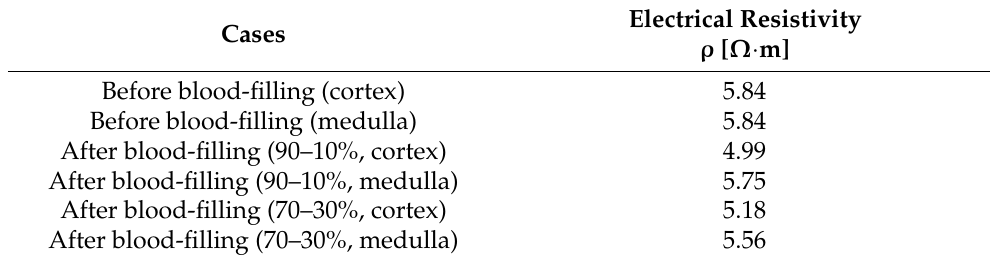
Table 2. The electrical resistivity of kidney tissues a according to blood distribution.